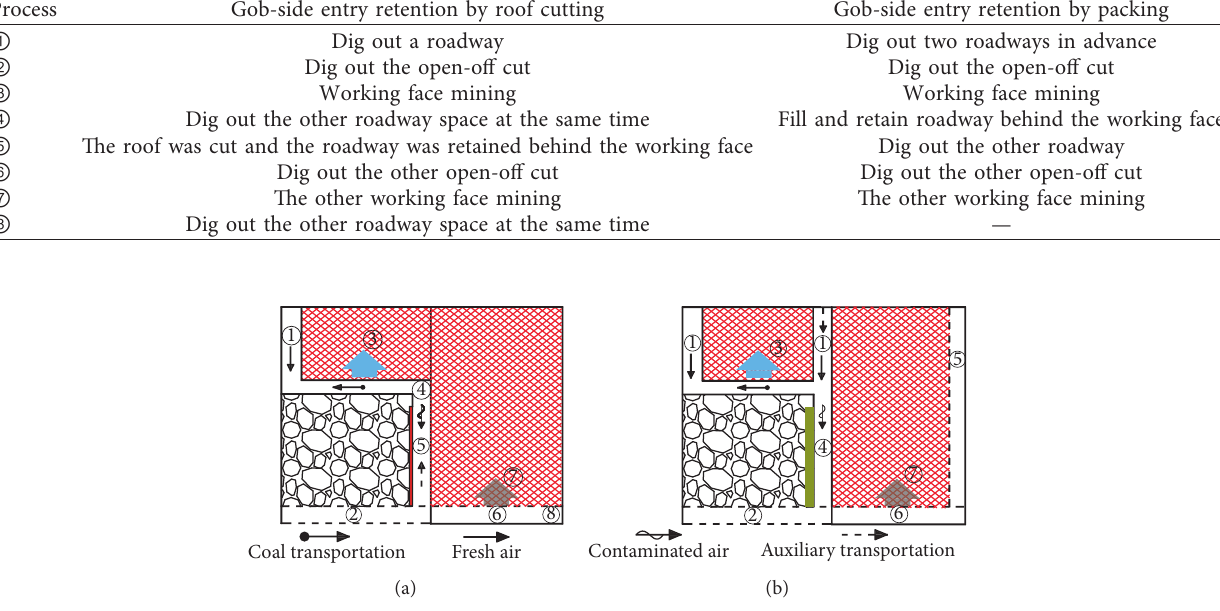
Figure 2: Plan view of the comparison of the new method with roadside roof cutting with the traditional method of roadside packing: (a) new method with roadside roof cutting; (b) traditional method with roadside packing.